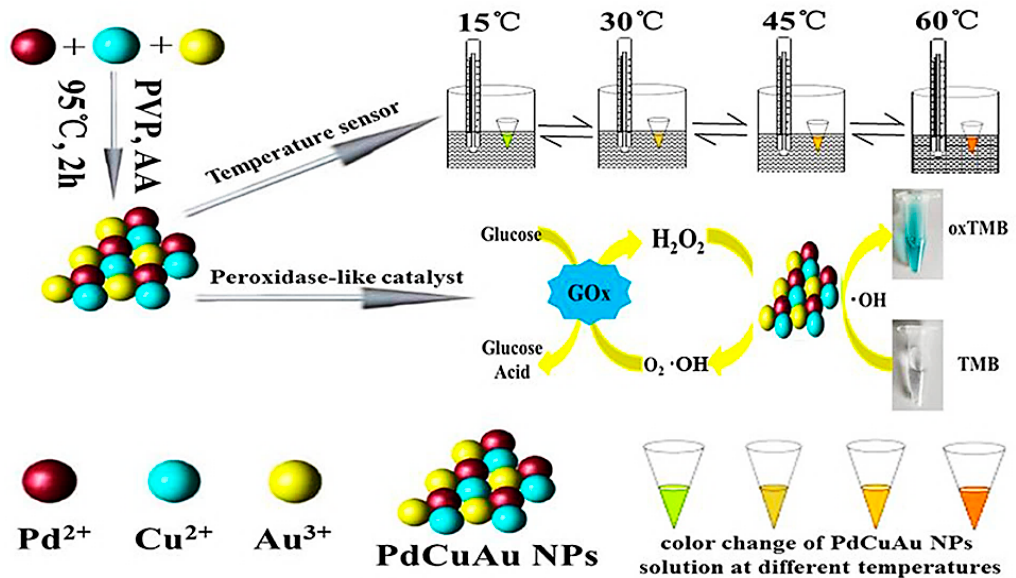
Figure 12. Pd-Cu-Au trimetallic NPs synthesized to be applied as temperature sensors and for colorimetric H 2 O 2 detection as well as glucose with enzyme mimic. Reused from [122]. An Open Access Article, (CC BY 4.0).